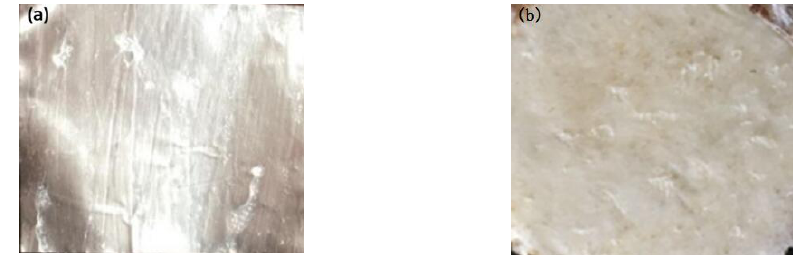
Figure 12. The tensile fracture morphology of sample 3-2 (( a ) aluminum foil; ( b ) DSPE).